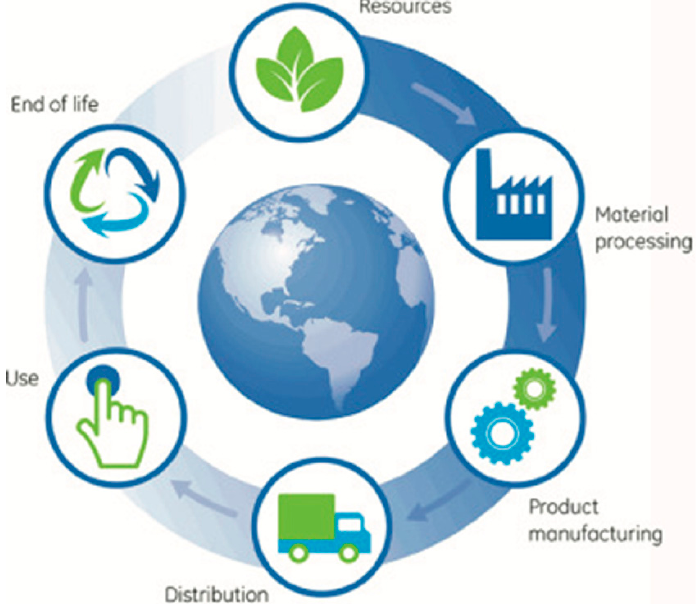
Figure 12. Components of life cycle assessment [153]. This figure was taken from Reference [153] with due permission from the publisher.